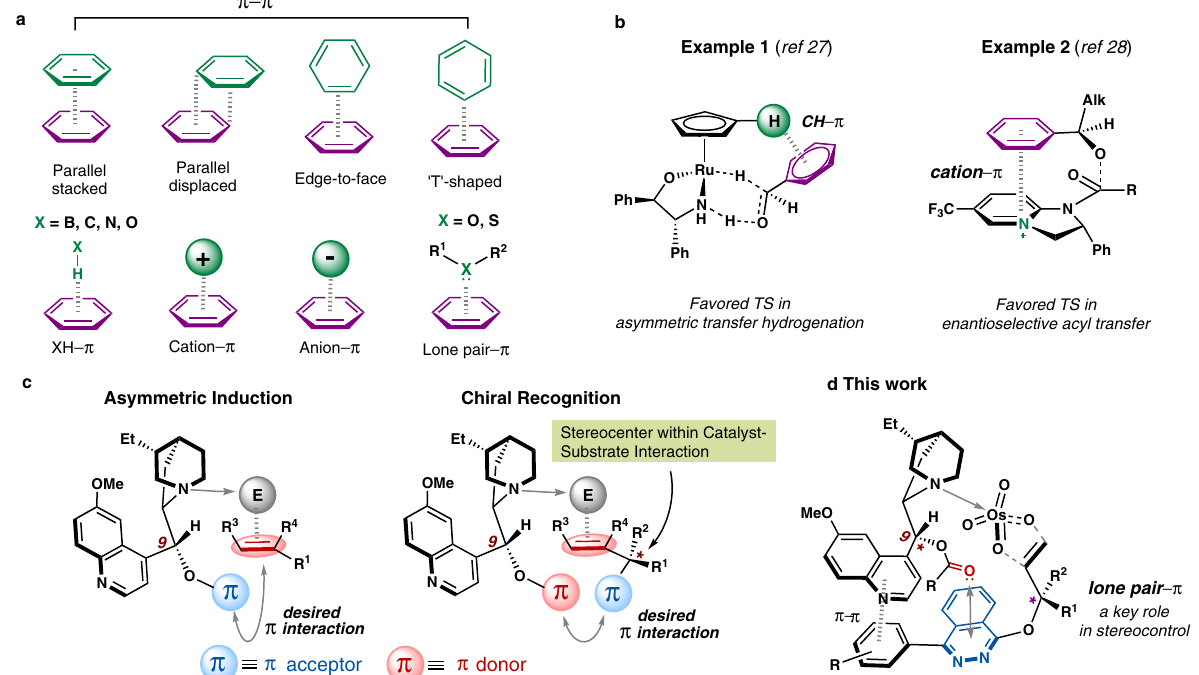
Fig. 1 Orchestrated non-covalent π interactions as a crucial design element in asymmetric catalysis. a Non-covalent interactions involving π systems. b Representative examples using non-covalent π interactions to rationalize the observed enantioselectivities. TS, Transition State. c Designing cinchona alkaloids-based, bi -functional catalysis modes using non-covalent π interactions for both asymmetric induction (left) and chiral recognition (right). E: electrophiles. d Lone pair – π interaction as a key stereocontrol element in asymmetric dihydroxylation-based kinetic